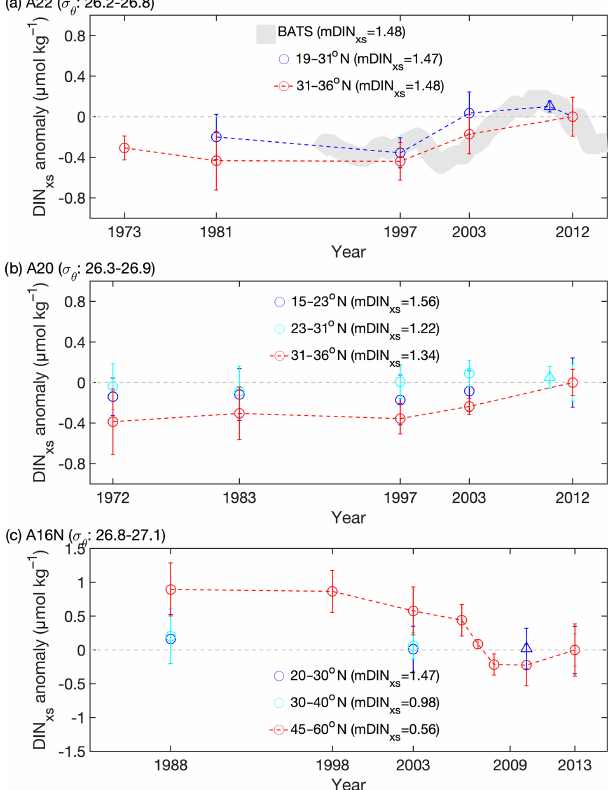
Figure 3. Temporal trends of DIN xs anomalies (dots) for the cor- responding latitude interval for the subsurface potential density in- tervals σ θ along the three meridional transects (a) A22, (b) A20, and (c) A16N in the NAtl. Data from A05 obtained in 2010 at three crossover sites are also shown (triangles). mDIN xs values in paren- theses indicate the mean DIN xs in the GO-SHIP dataset. For each subregion, DIN xs anomalies indicate individual DIN xs values mi- nus the mDIN xs values from the GO-SHIP dataset. Note that the positive anomalies indicate higher values than the GO-SHIP data. The selected σ θ intervals are typically located at the depth intervals of 200–600m with DIN xs maximum along each transect. Note that the selected σ θ interval ( = 27.2–27.6) in the subpolar region along A16N (45–60 ◦ N) is different from that in the subtropical region, as σ θ for 200–600m depth becomes larger in the high-latitude region. Besides repeat cruises of these transects, the datasets from other cruises with similar tracks (Fig. 1) in the subregions were included for comparison. The DIN xs values were corrected by the changes in AOU to remove the contribution from remineralization of organic matter (see text). The data points connected by the dashed lines in- dicate that the (cid:49) DIN xs values were statistically significant in these regions ( p< 0 . 05, Student’s t test and ANOVA with Games–Howell test). Otherwise, the data that were statistically unchanged are not connected by the dashed lines. The smoothed trend using the 5- year robust locally weighted scatterplot smoothing filter for DIN xs anomalies of the STMW at the same depth ranges of the BATS site (near A22) is also shown (the gray shading in a ). The gray dashed lines indicate that the DIN xs anomaly equals to zero. The size of symbol for DIN xs indicates the error of DIN xs